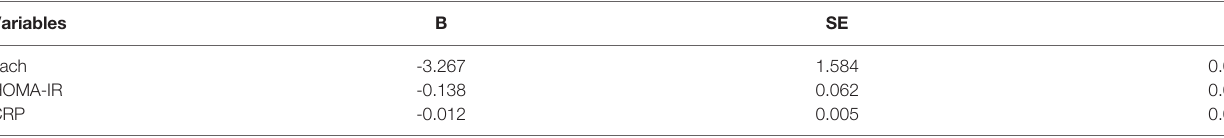
TABLE 2 | Stepwise linear regression analysis of risk factors associated with testosterone in